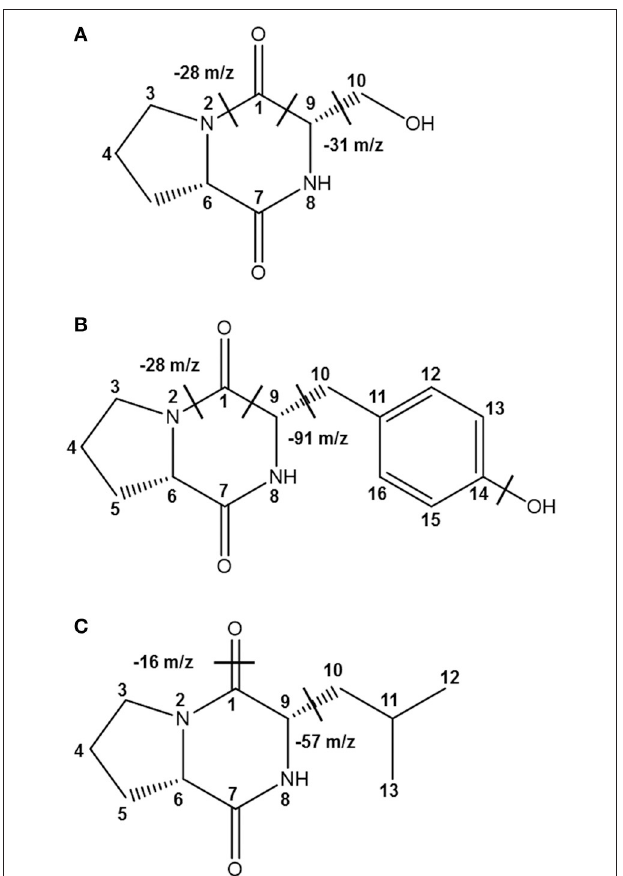
FIGURE 5 | The identified CDPs from fractions KF1, KF2, and KF4 from Chinese cabbage kimchi inoculated with Ln. mesenteroides LBP-K06 starter cultures. EI fragmentation patterns are indicated. Structural units separated by chemical bonds are divided by dashed lines. Mass fragmentation pattern under EI of these compounds have been revealed to be (A) cyclo(Ser-Pro)